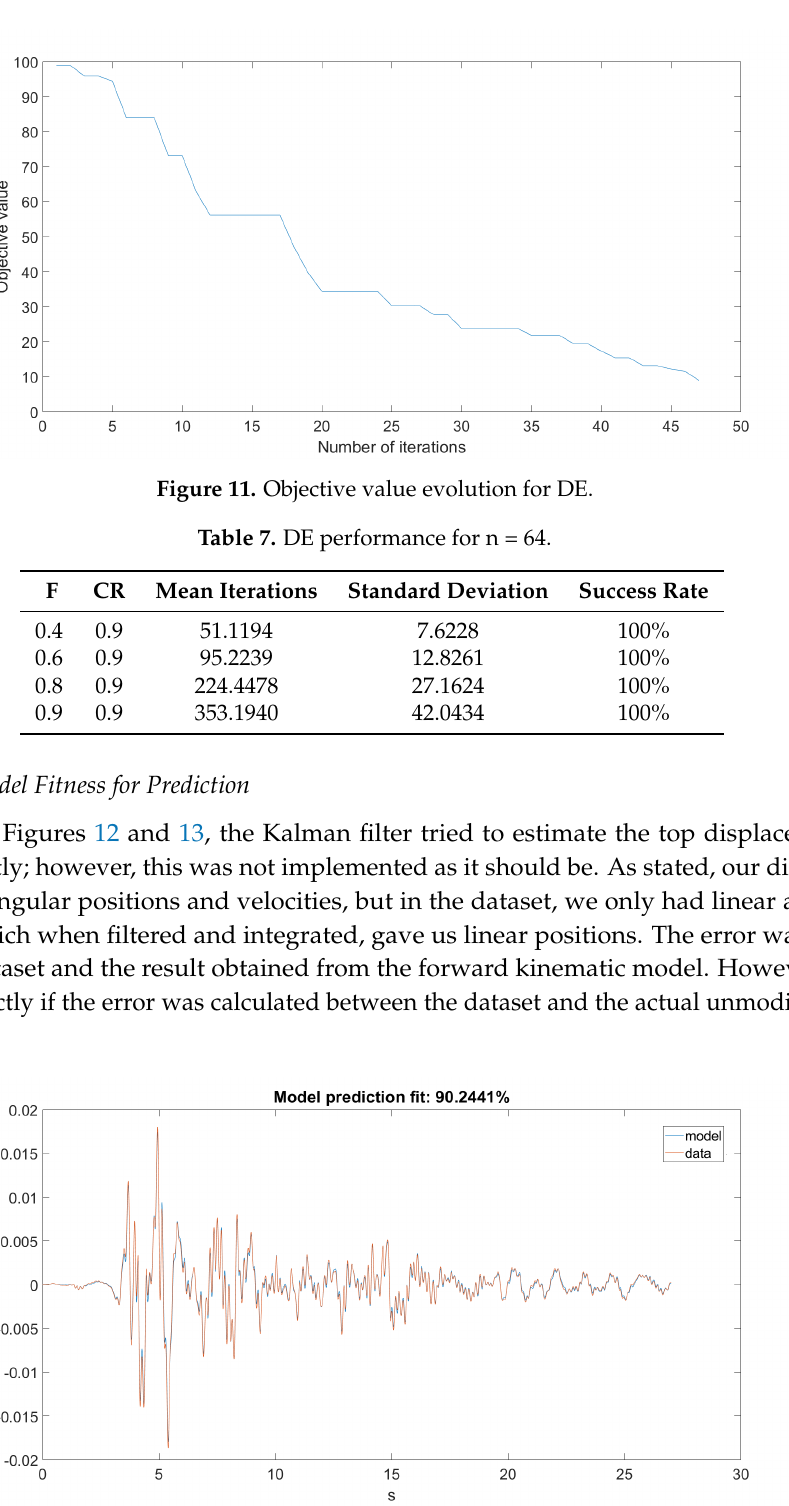
Figure 12. Prediction for Ground Motion